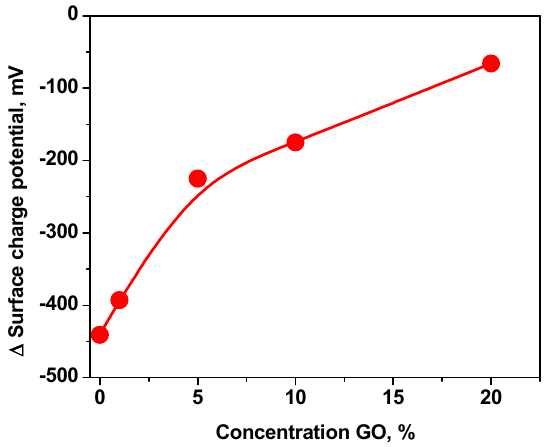
Figure 4. Variation in surface potential of P(VDF-TrFE) / Graphene oxide composite fibers with GO concentration relative to aluminum foil.